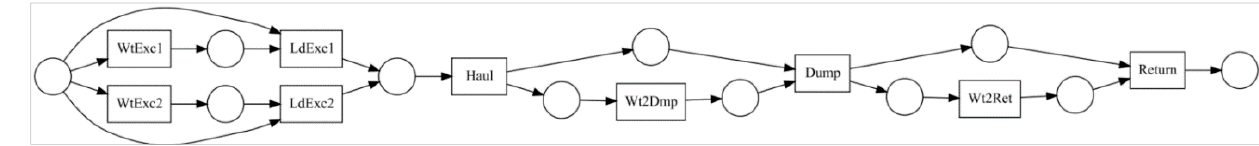
Figure 9. Discovered Petri net using α -algorithm.